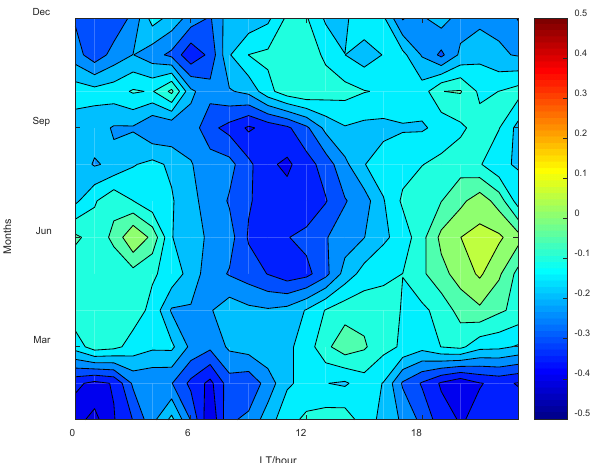
Figure 4. Diurnal variation of TEC longitude difference index R e/w in East Asia in 2018 and 2019, two low solar activity years.